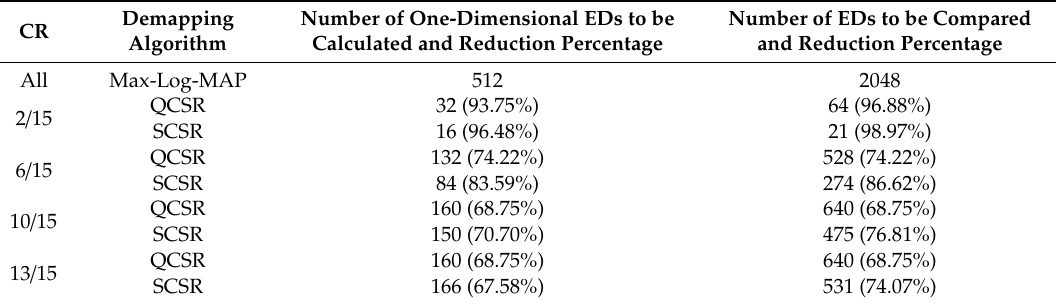
Table 1. Complexity comparison when demapping 2D-256NUC.